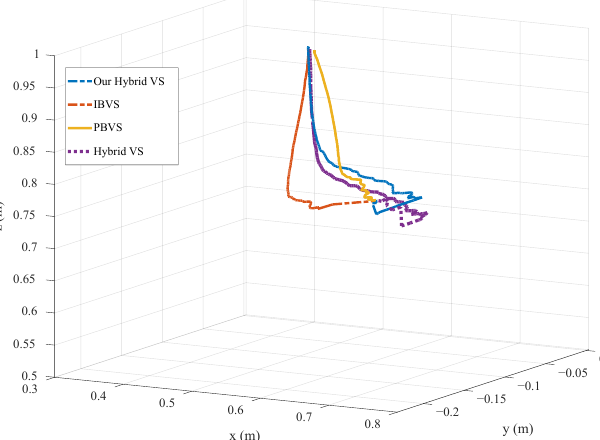
Figure 7. The real world camera (EE) trajectory in different methods for the same scenario in Figure 6. It stems from the fact that translation in X -axis and Y -axis of the camera velocities are computed directly from the image space, while the rest are computed from 3D reconstruc- tion of the environment. Furthermore, as compared to HVS and PBVS, the object in DHVS is less likely to be lost from the camera FOV. This conclusion was reached by comparing the maximum feature error in Figure 6d to the one in Figure 6a,c, which is less. The larger the error, the more likely the feature lost from the camera